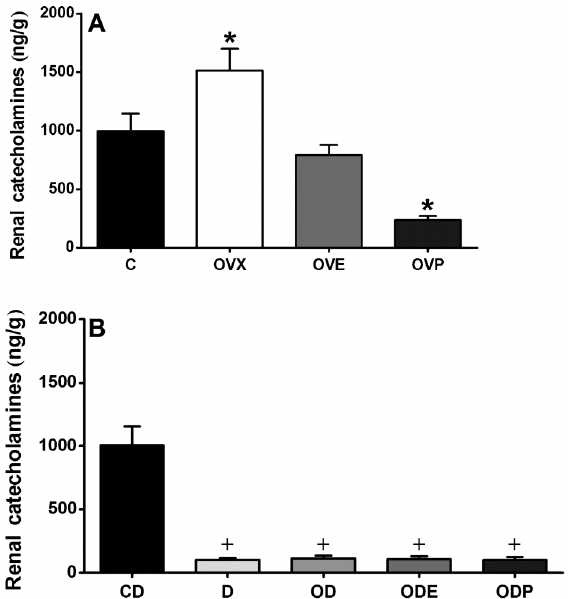
Figure 1. Renal catecholamine content in female rats. A , Control (C), ovariectomized (OVX), OVX with 17 b -estradiol benzoate (OVE, 2.0 mg ? kg -1 ? day -1 , sc ), and OVX with progesterone (OVP, 1.7 mg ? kg -1 ? day -1 , sc ), both for 7 days. B , Sham-denervated (CD), denervated (D), D ovariectomized (OD), OD with 17 b - estradiol benzoate (ODE), and OD with progesterone (ODP), both for 7 days. Data are reported as means±SE (n=8). *P , 0.01 and + P , 0.01 compared to C and CD, respectively (ANOVA and Tukey test).